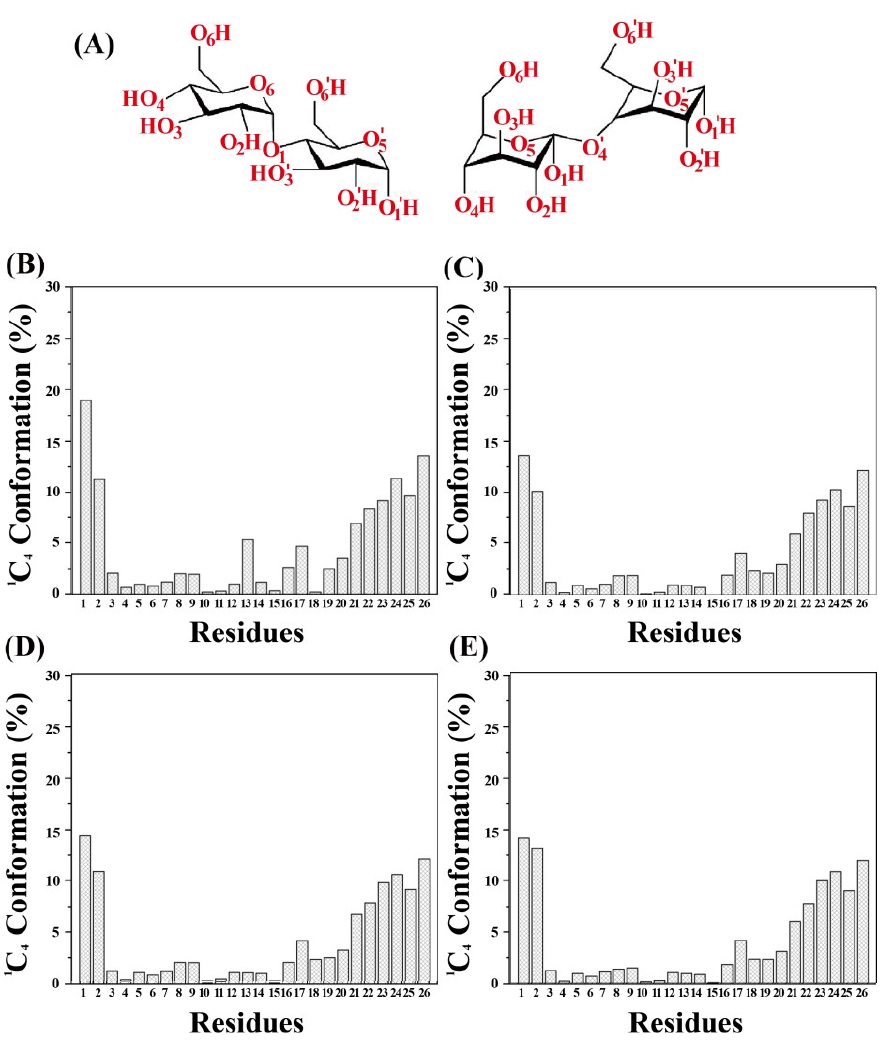
Figure 9. ( A ) Conformational structures of 4 C 1 (left) and 1 C 4 (right); The distribution proportion of 1 C 4 chair conformation of glucose residues of amylose molecule in both the single-strand system ( B ), complex1 ( C ), complex2 ( D ), and complex3 ( E ).